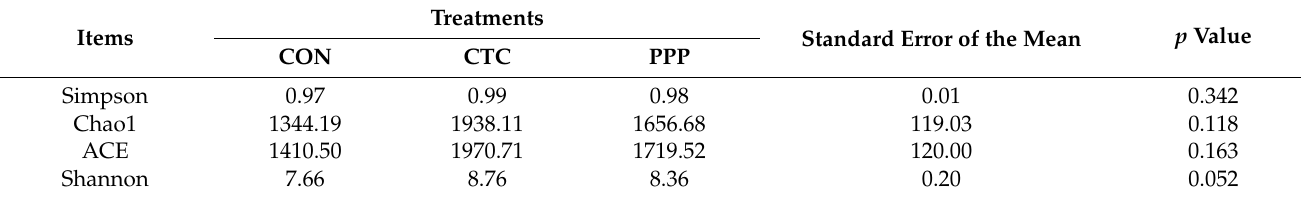
Table 5. Analysis of microflora diversity of colonic contents in each treatment